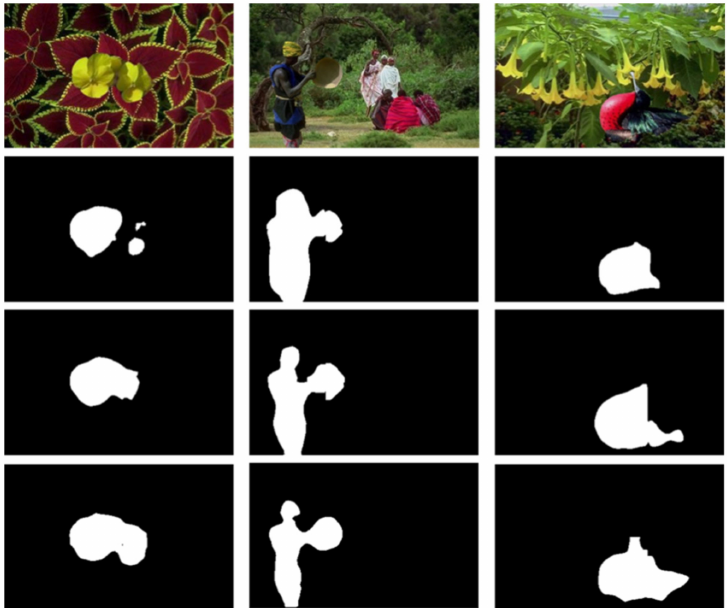
Figure 4. First row: tampered images; second row: the prediction of model trained with seg4; third row: the prediction of model trained with seg_total; fourth row: the prediction of model trained with seg_total, self-attention, and OHEM.